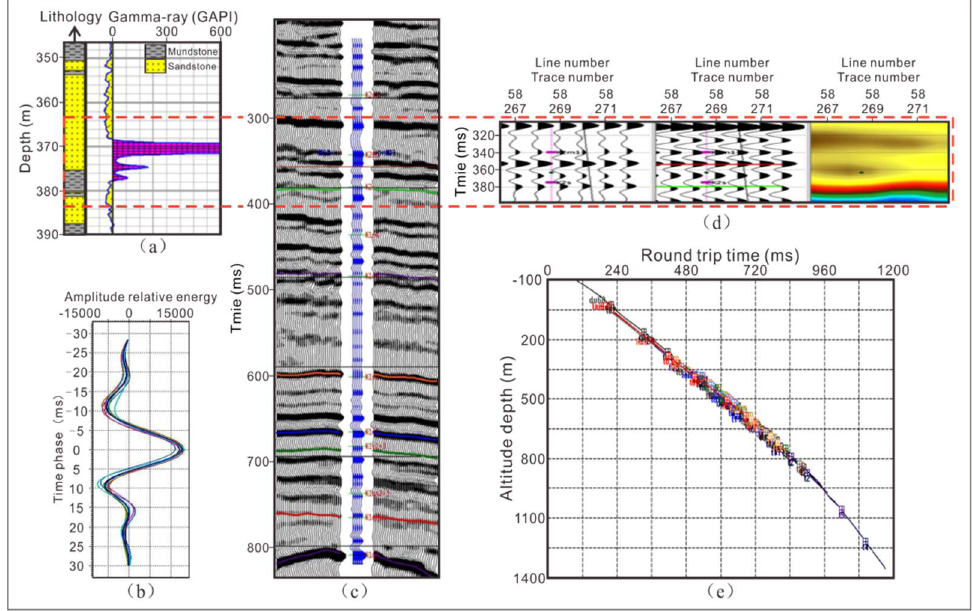
Figure 2. Accurate location and well seismic calibration of target uranium reservoir. ( a ) Drilling and logging data, ( b ) Wavelet extraction, ( c ) Synthetic seismogram, ( d ) Measured seismic data (left), synthetic seismogram (middle) and their correlation (right), ( e ) Consistency check for the time-depth relationship of multi wells.